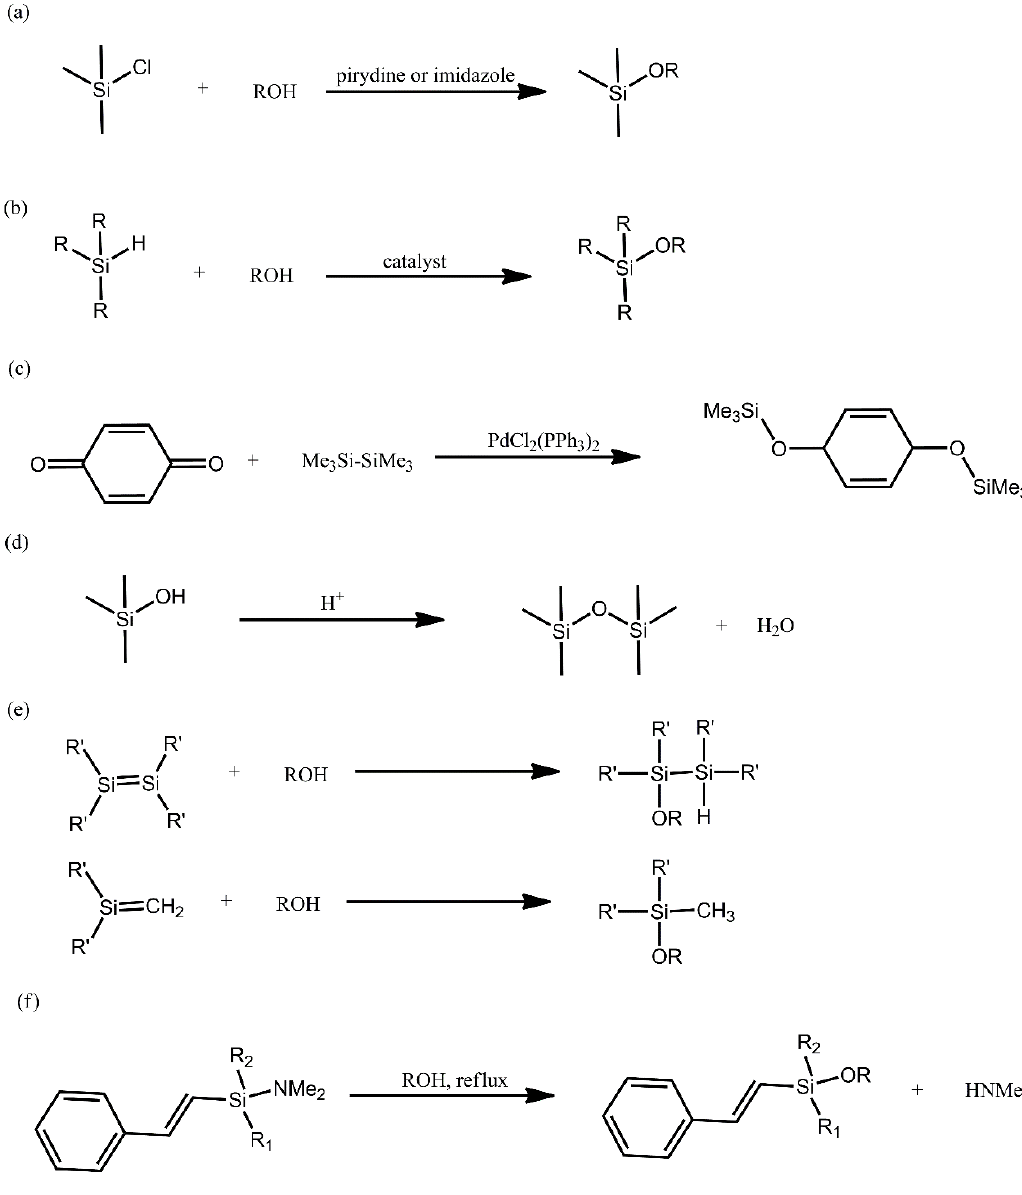
Figure 1. Overview of the most common synthetic methods for producing siloxanes.